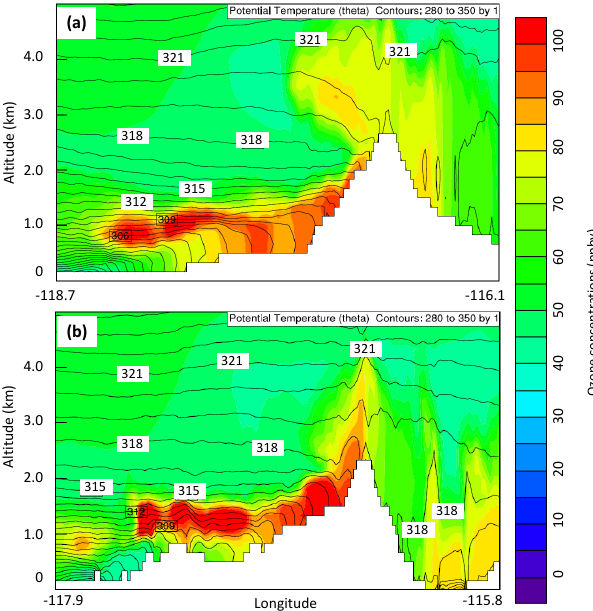
Figure 10. Vertical distributions of ozone along cross-section A’A (a) and B’B (b) shown in Fig. 1b at 22:00UTC of 17 July 2005. The contours are potential temperature starting at 280K with 1K